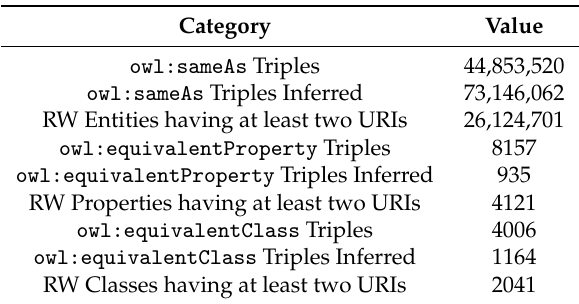
Table 8. Statistics for equivalence